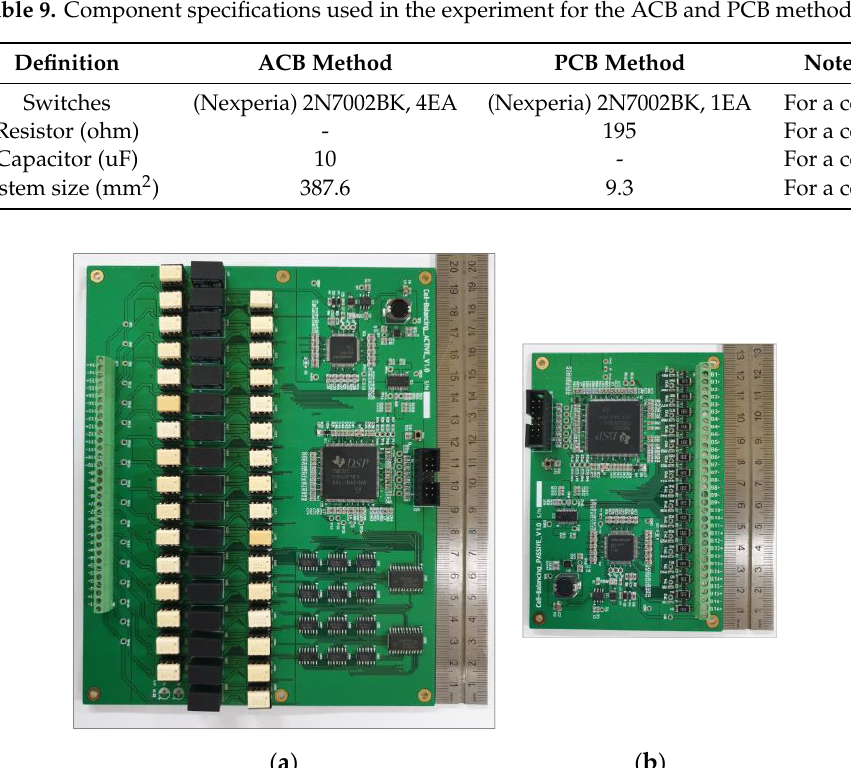
( a ) ( b ) Figure 9. Experimental waveforms according to cell-balancing method: ( a ) the ACB method; ( b ) the PCB method. Table 10. Comparison between the ACB method and the PCB method by experimental results. Definition